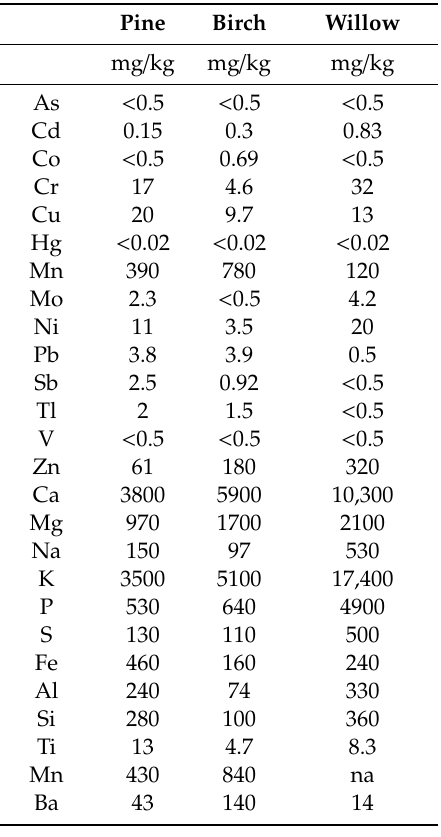
Table 2. Minerals content in unwashed biochars. Pine